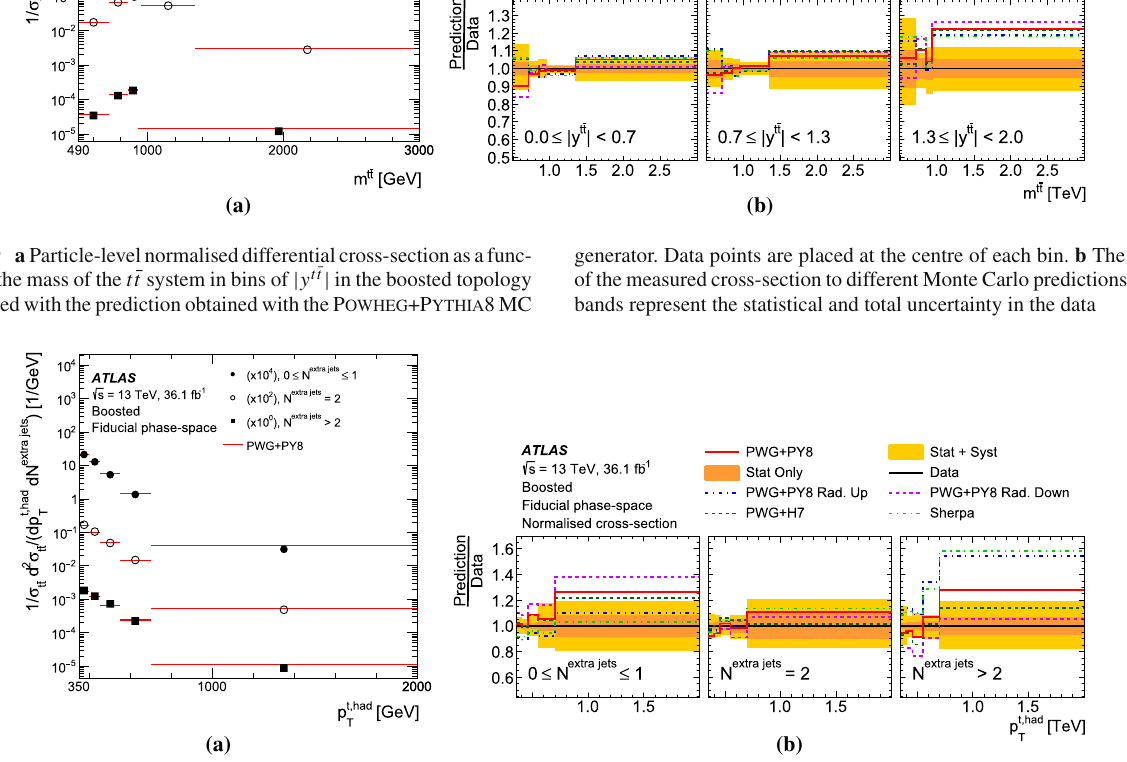
points are placed at the centre of each bin. b The ratio of the measured cross-section to different Monte Carlo predictions. The bands represent the statistical and total uncertainty in the